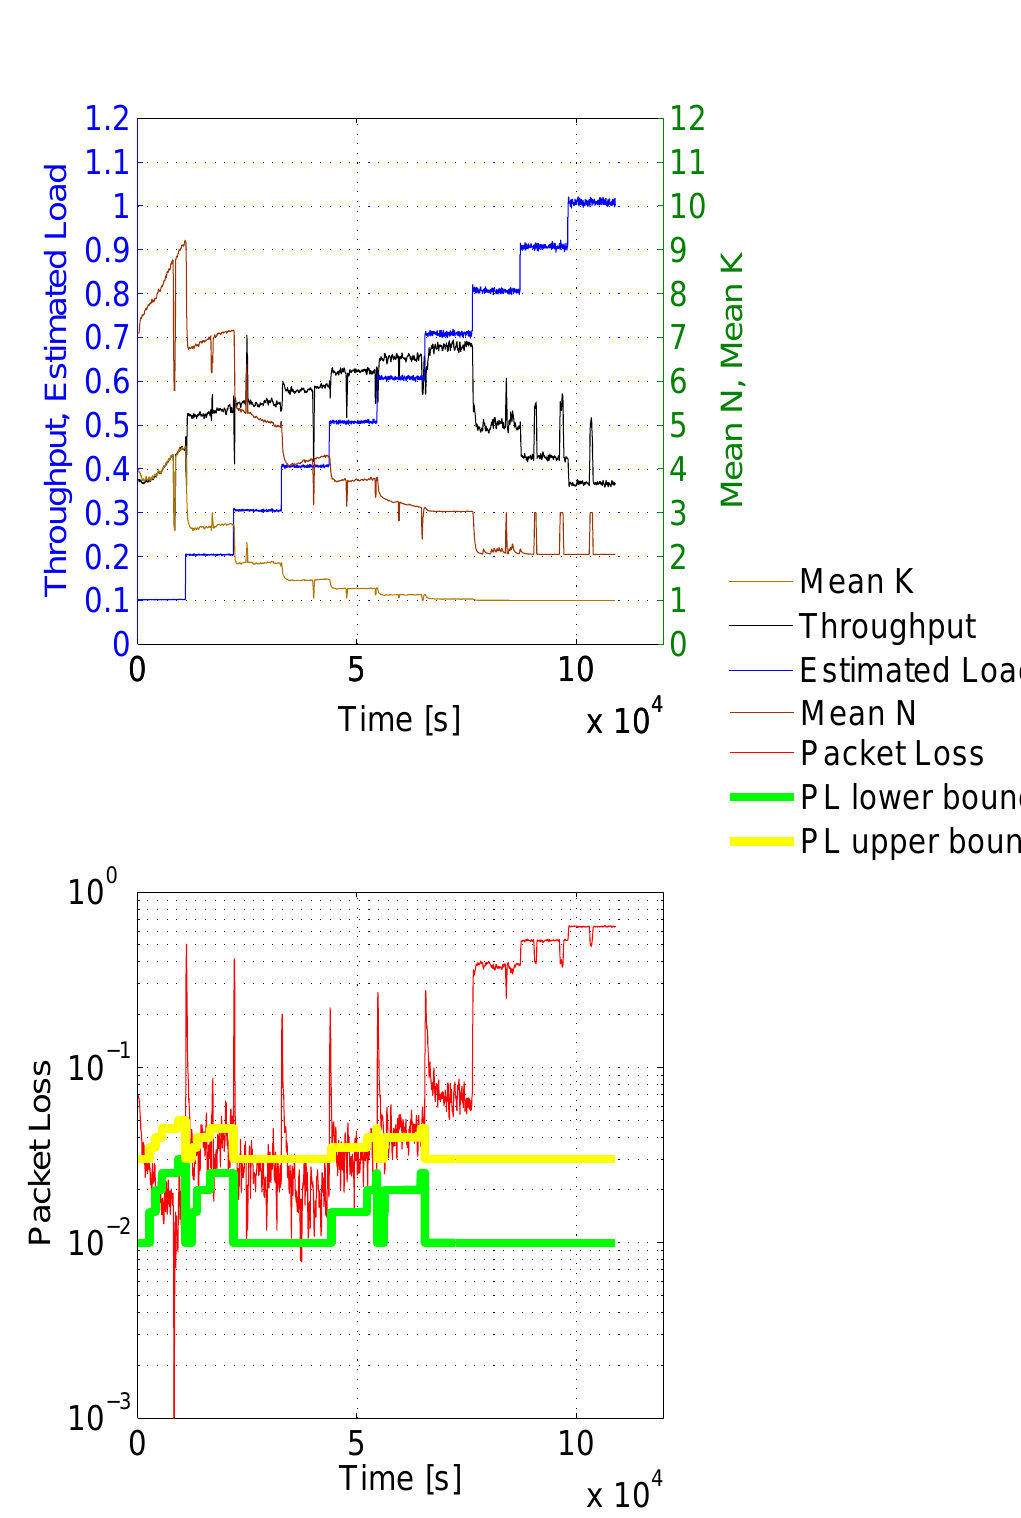
Figure 4. Throughput and Packet Loss for LC algorithm, linear code set C as in table ??